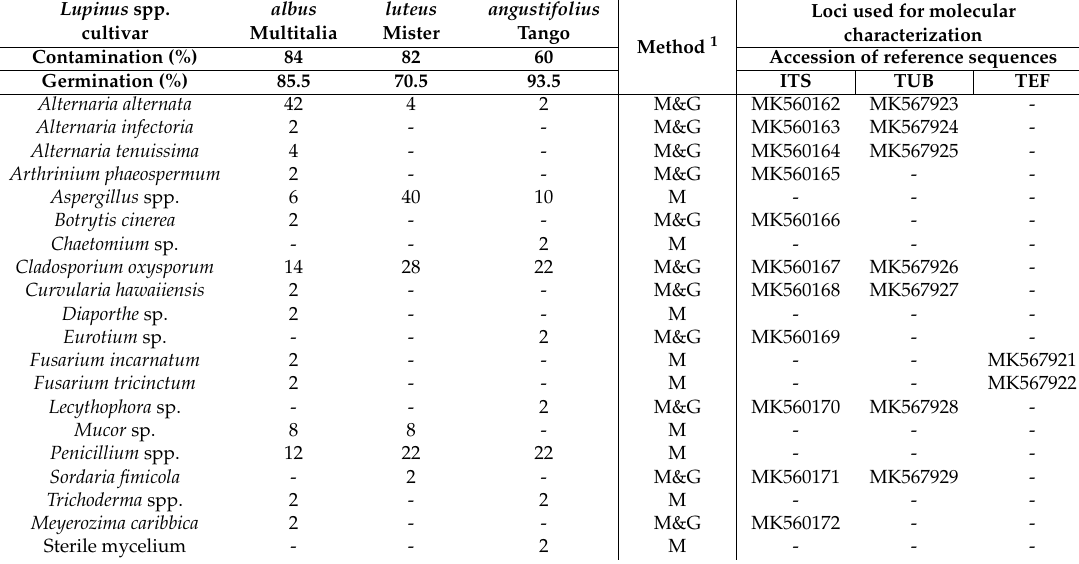
Table 1. Percentage of contaminated seeds and mycoflora composition of the studied lupin varieties. Methods and accession number of genetic loci used for the characterization of main contaminants are also reported. Lupinus